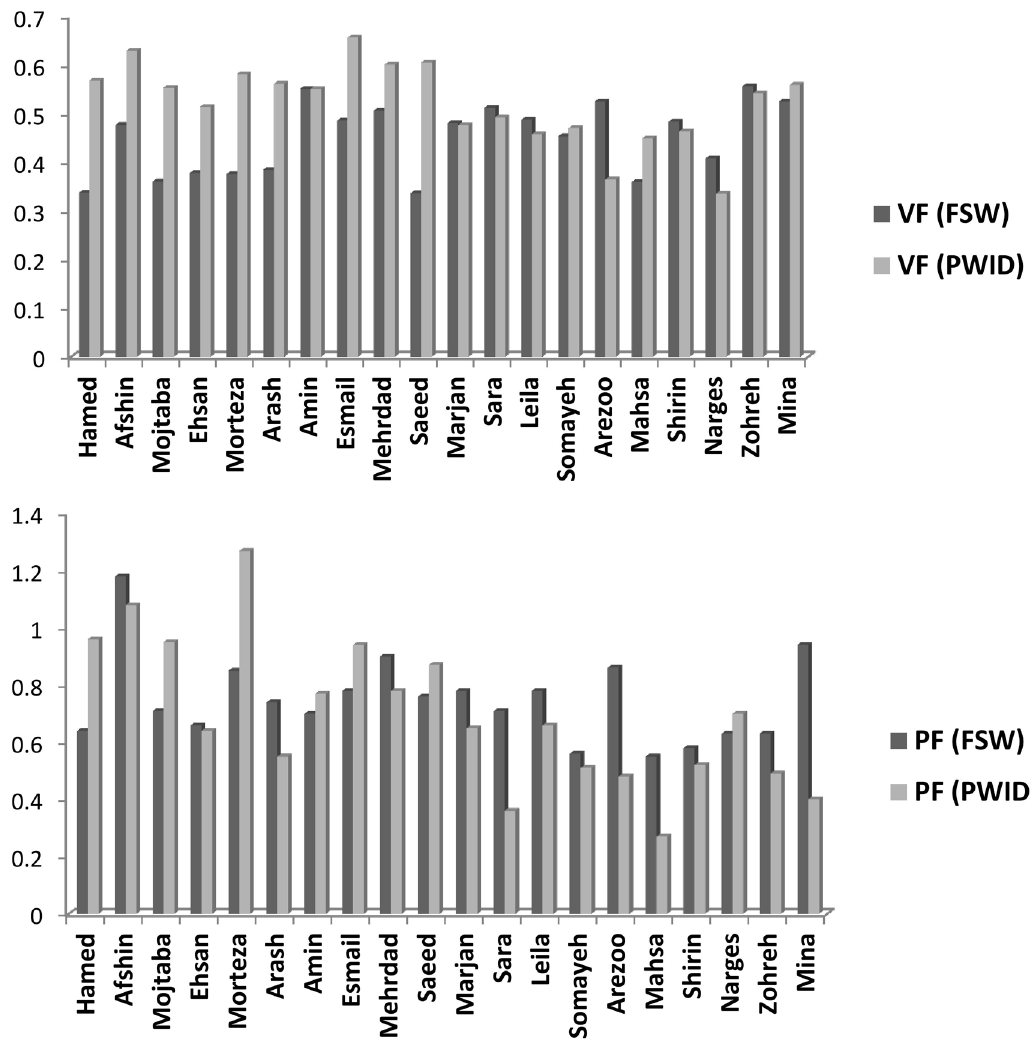
Figure 2. Estimation of Visibility Factor (VF), (top panel), and Popularity Factor (PF), (bottom panel), based on all 20 names.